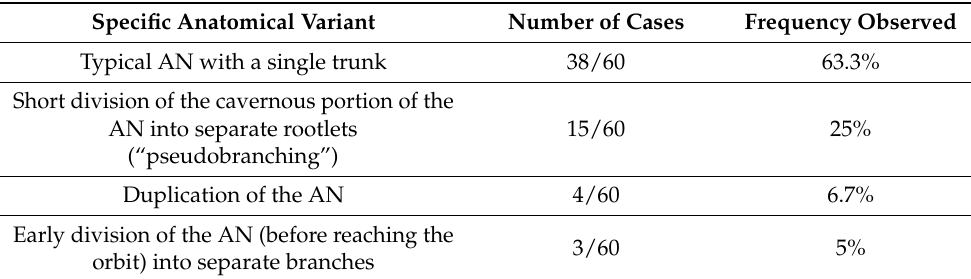
Table 1. The frequency of the AN anatomical variations found in the examined sample.